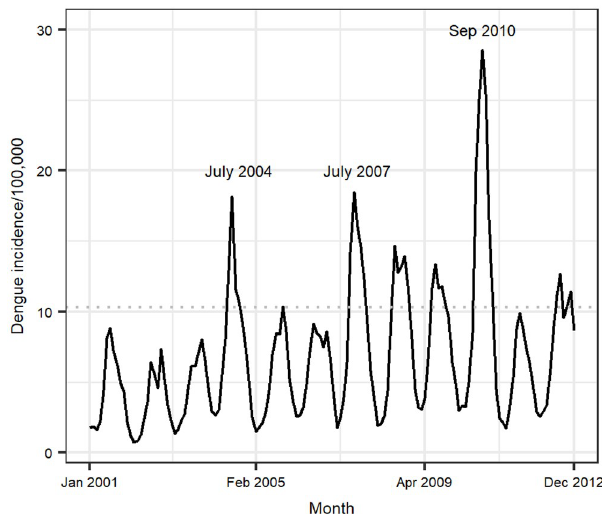
Fig 5. Inter-annual trends in dengue incidence in Vietnam. Months that had higher than expected peaks in the disease incidence are indicated in text within the graph. The horizontal dotted line at an incidence of 10.31 a threshold that was used to demonstrate changes in the peak incidence of the disease before and after mid-2005.